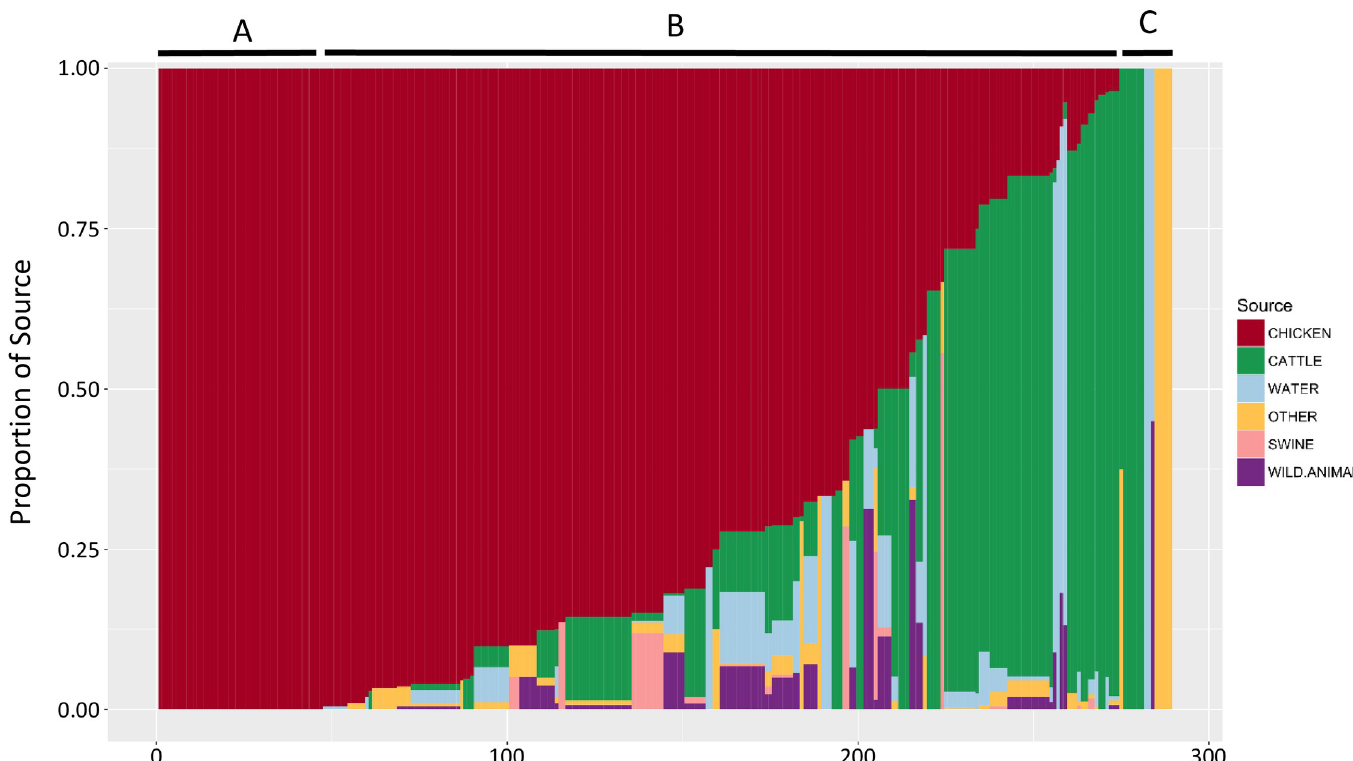
Fig 4. Source attribution for human campylobacteriosis cases in Nova Scotia. The relative contribution of non-human sources for each clinical subtype is displayed for 289 clinical cases based on the number of isolates in the C3GFdb. Source vectors have been clustered for visualization purposes.